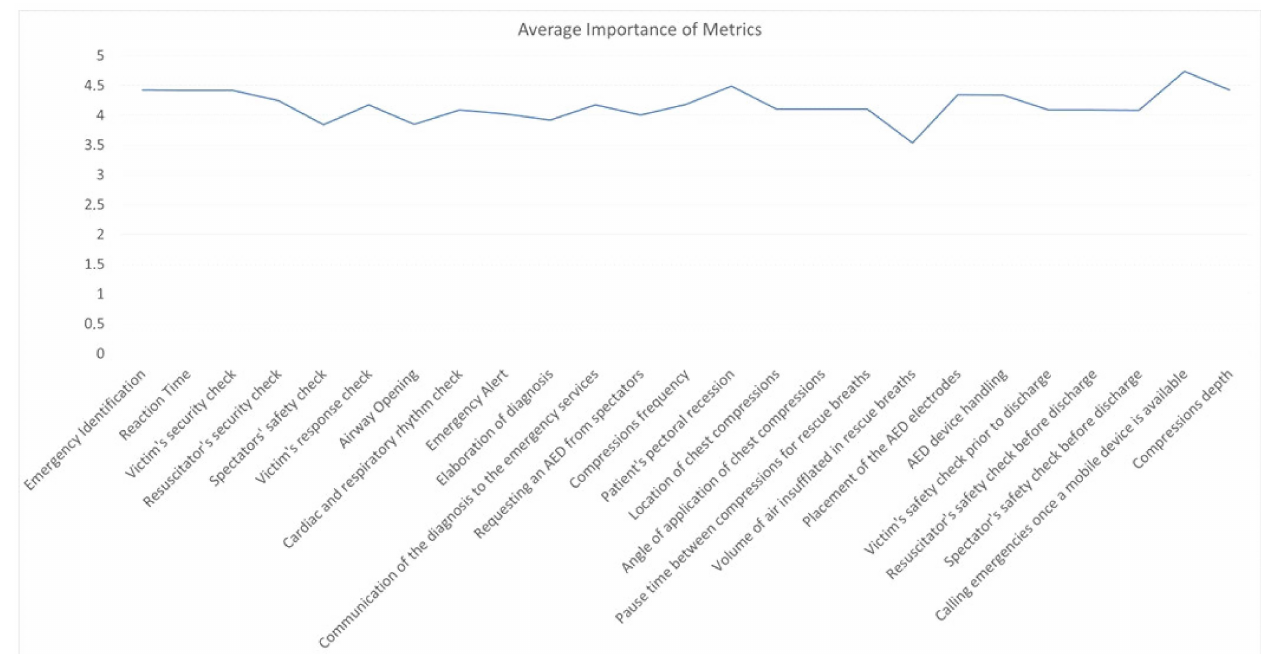
Figure 10. Average values of the importance for each metric mentioned in Table